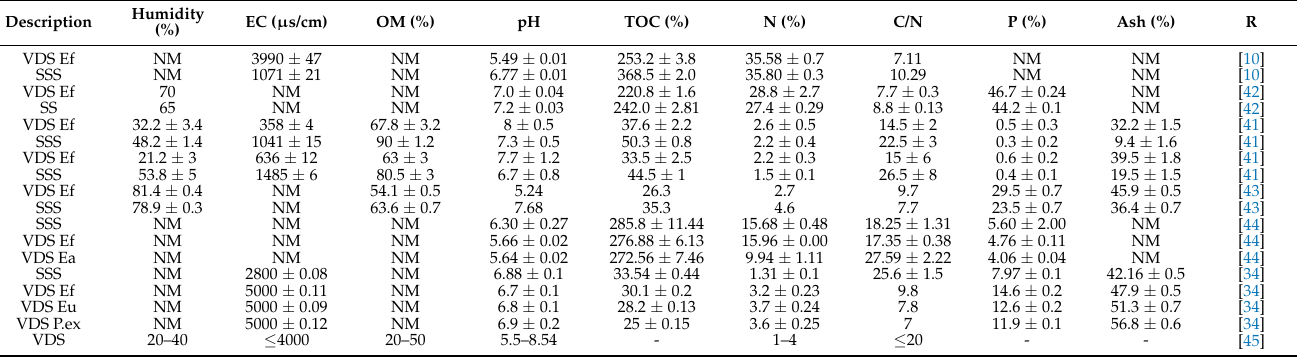
Table 1. Physico-chemical characteristics of simple and vermicomposted SS (data from